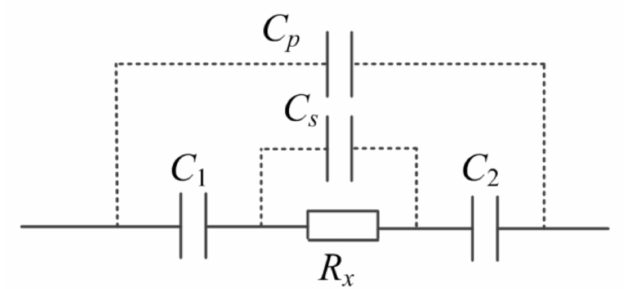
Figure 1. The equivalent circuit of a typical C 4 D